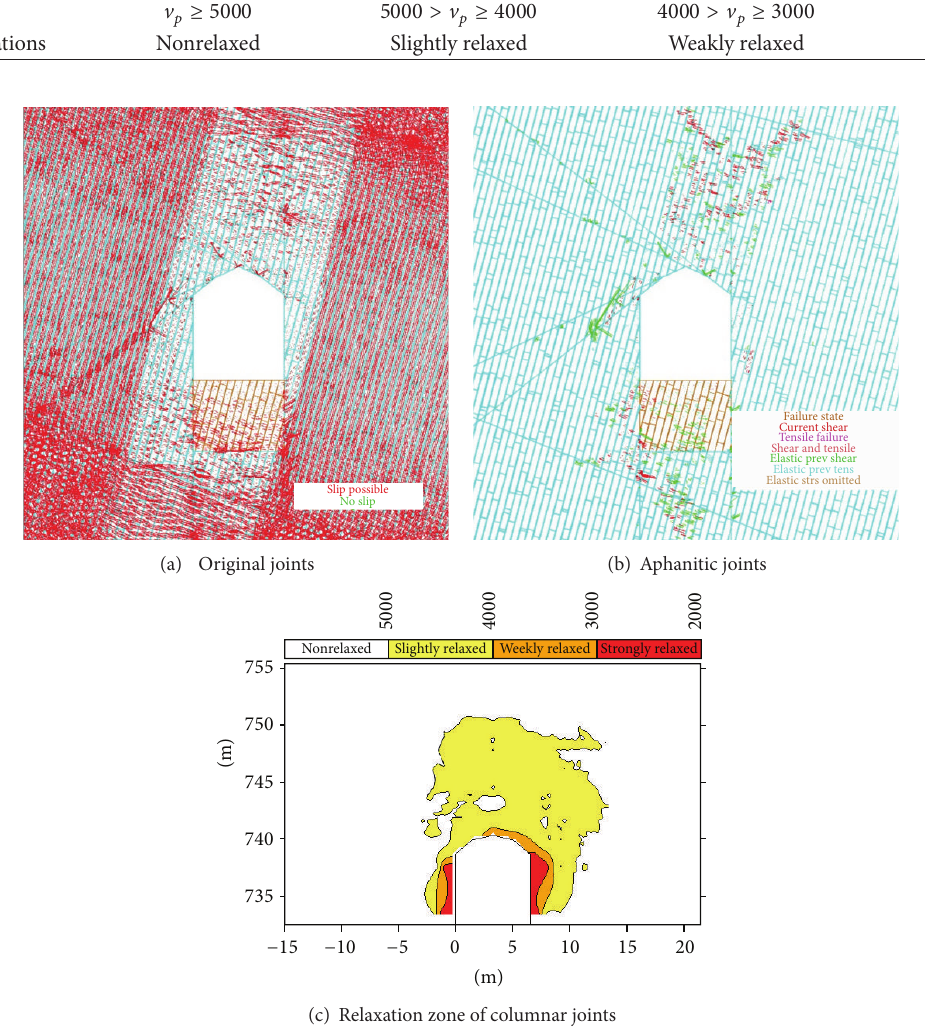
Figure 9: Relaxation zones of joints after excavation of the second